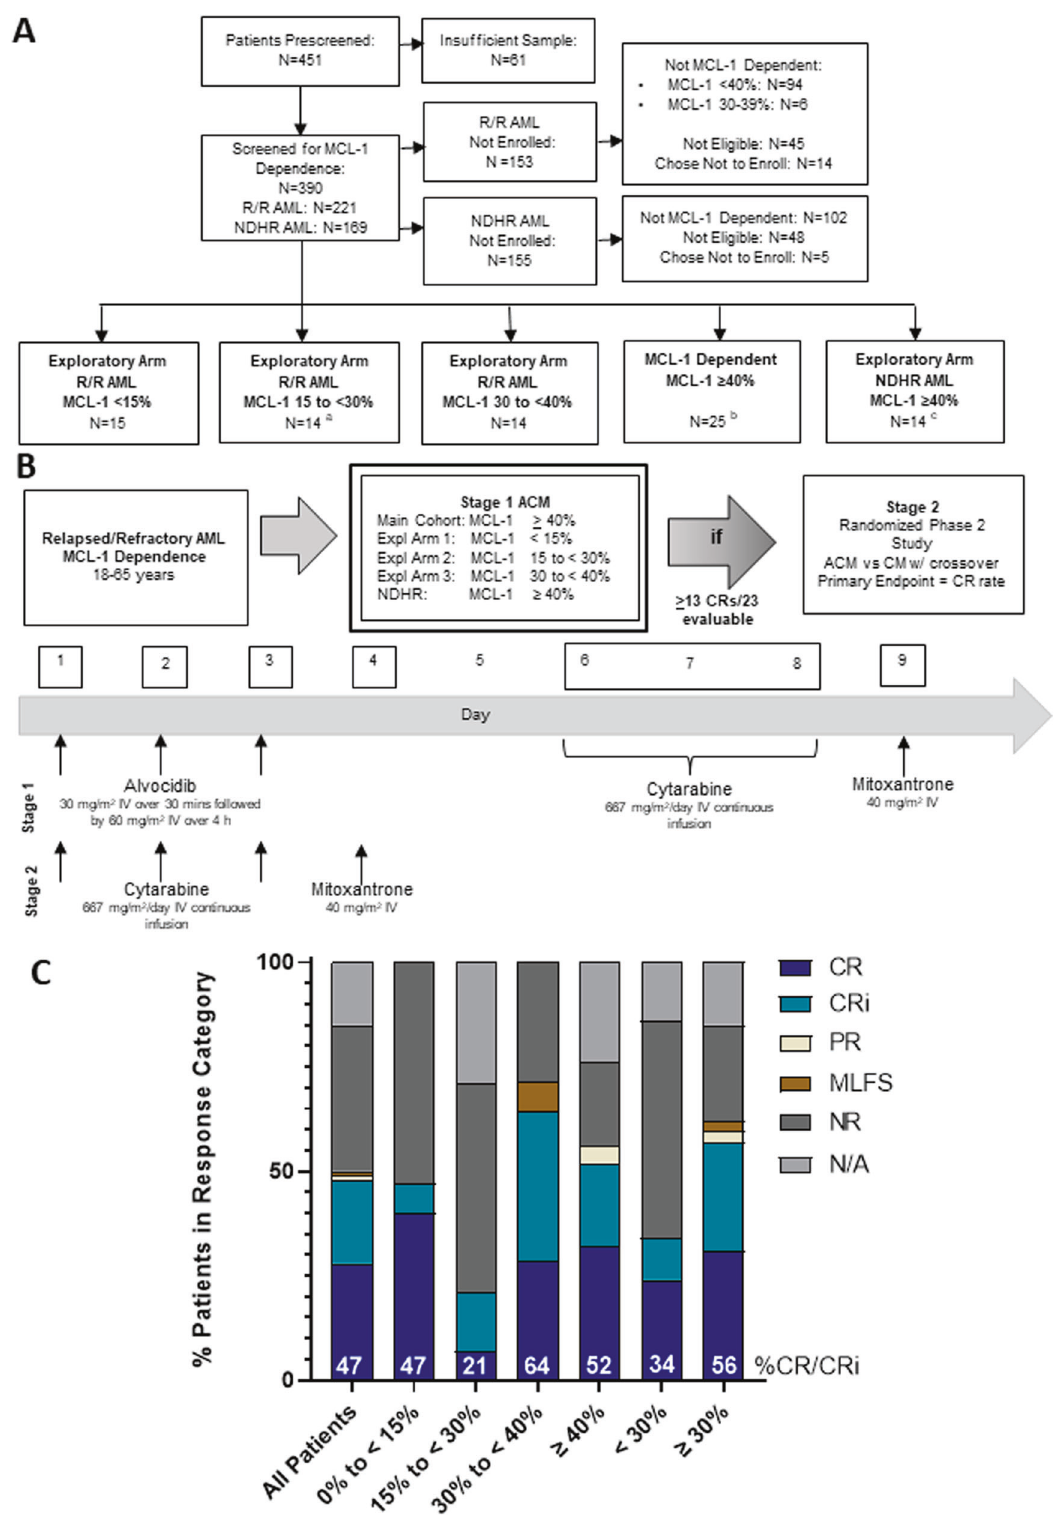
Fig. 1 Study diagram, consort diagram, and response rate. A Consort diagram. Not evaluable for response: a Did not receive mitoxantrone due to death (enterocolitis and sepsis, n = 1); b Suicide attempt prior to response assessment ( n = 1) and acute decompensation due to septic shock prior to completion of cytarabine ( n = 1); c Did not complete alvocidib cycle 1, day 2 due to TLS or day 3 due to tachycardia, tachypnea, hypotension, and worsening liver function tests. Patient eventually withdrew consent ( n = 1). B Study diagram. C Response rates of alvocidib in combination with cytarabine and mitoxantrone in relapsed/refractory AML. Percentages within each column indicate response in that cohort. CRi CR with incomplete recovery, PR partial remission, MLFS morphologic leukemia-free state, NR no response, N/A no response assessment due to early